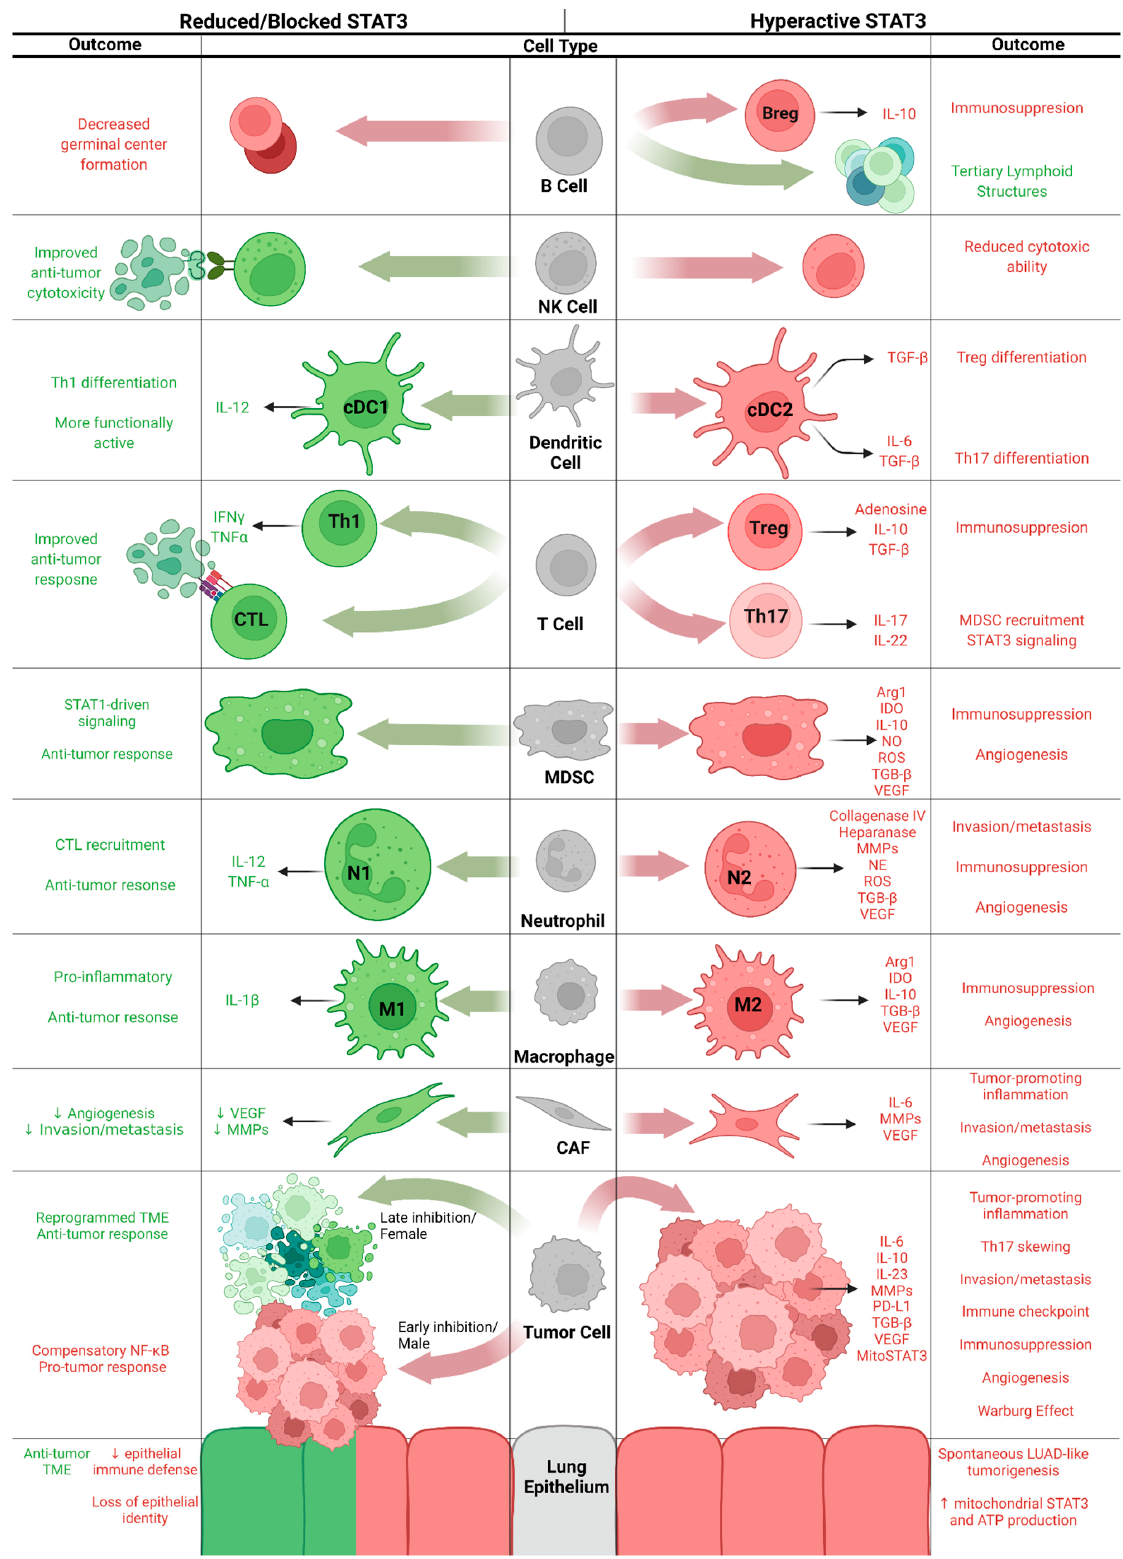
Figure 2. Cell type-specific effects of hyperactive and attenuated STAT3 signaling, with anti-tumor effects in green and pro-tumor effects in red. Figure created in BioRender.